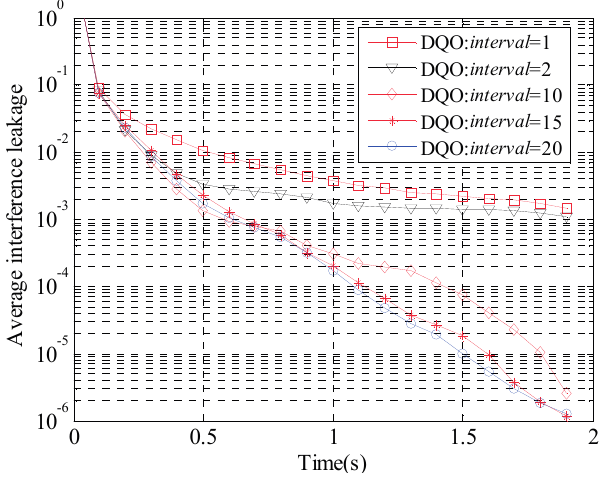
Figure 4. Convergence curves of the average interference leakage of DQO algorithm with interval = 1, 2, 10, 15, and 20 in (5 × 5, 2) 4